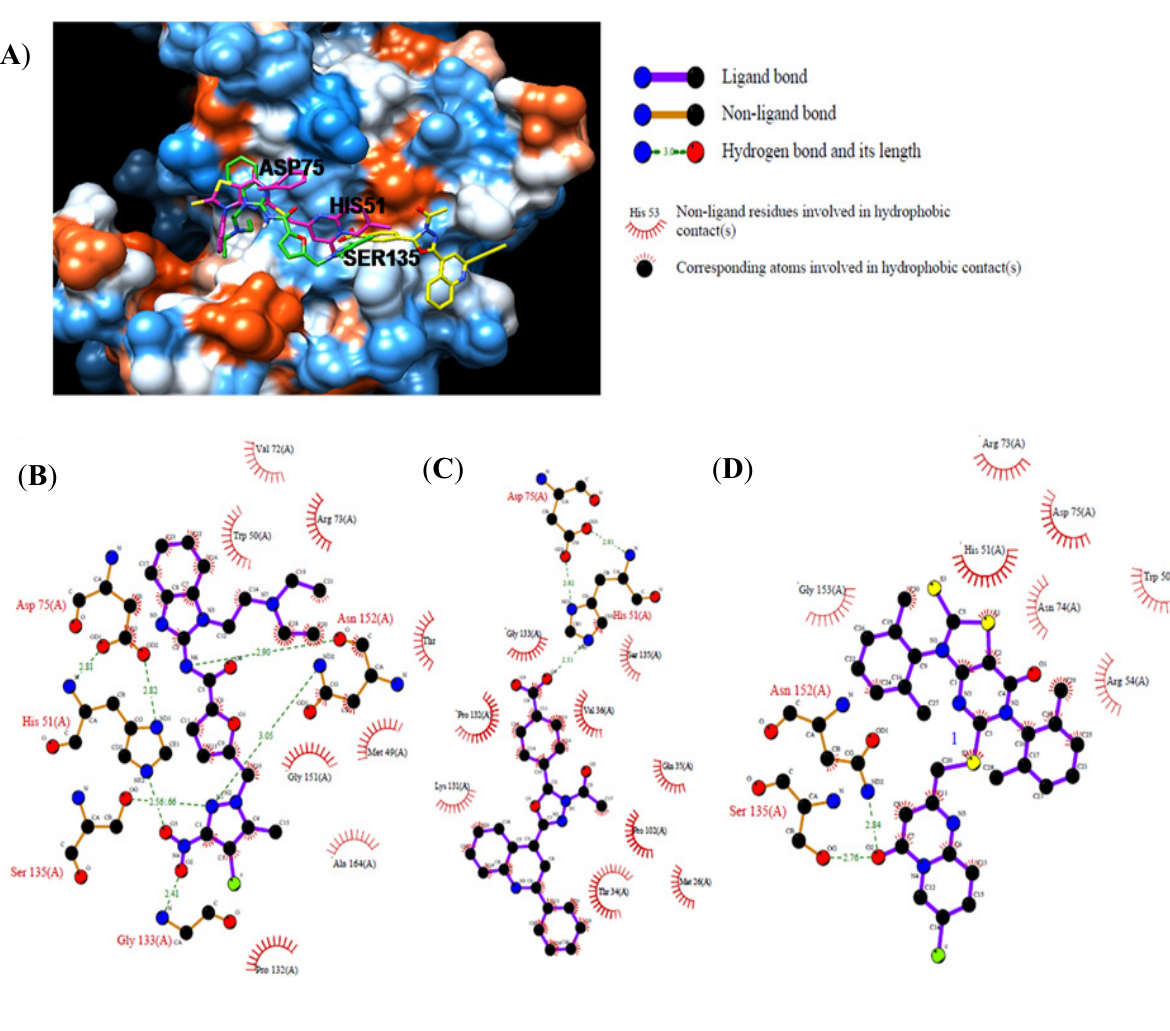
Figure 3. Computational docking and hydrophobic and H-bond interactions of compounds 2 , 14 , and 22 with residues in the NS3 pro active-site pocket. ( A ): comparison of binding modes of compounds 2 (green), 14 (yellow), and 22 (magenta) at the NS3 pro active-site pocket. ( B ), ( C ), ( D ): hydrophobic and H-bond interactions of compounds 2 , 14 , and 22 with amino acid residues in the NS3 pro active site, respectively. H-bond interactions are represented by green dashed